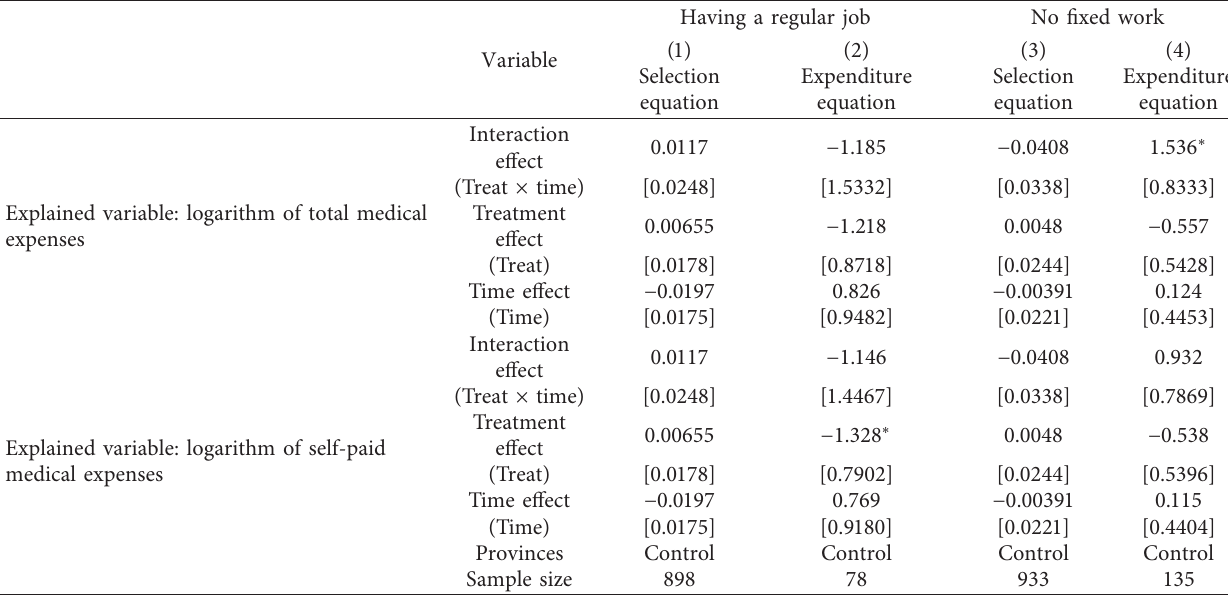
Table 7: Adverse selection and moral hazard